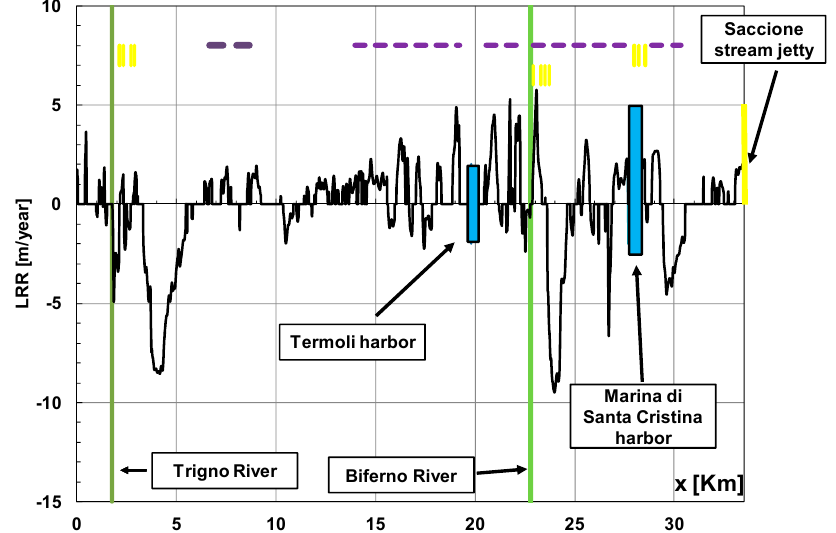
Figure 6. Linear regression rate (LRR) function during the period 2004–2016. Horizontal dashes indicate the detached breakwaters; the vertical dashes indicate groin fields.